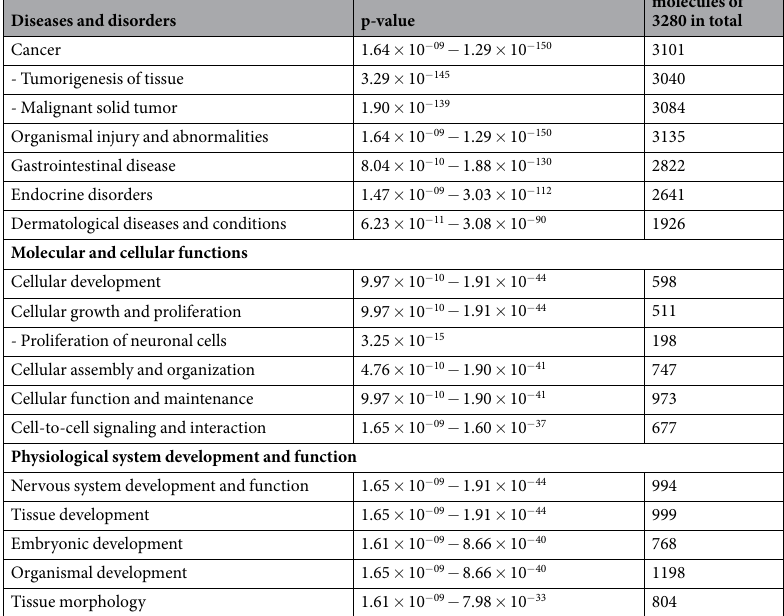
(zone I) in comparison to the peritumoral brain (zone III, Fig. 4b). The vast majority of all DEGs belonged to the protein-coding fraction of transcripts (Fig. 4c). In addition, known human pseudogenes and non-coding RNAs represented approximately 100 DEGs both in the downregulated and in the upregulated transcripts. A corresponding comparison of untreated versus treated GBM tissue (Fig. 4f) revealed 3470 significantly regulated (FDR < 0.01) transcripts. Here, 2071 DEGs were found to be significantly downregulated and 1399 significantly